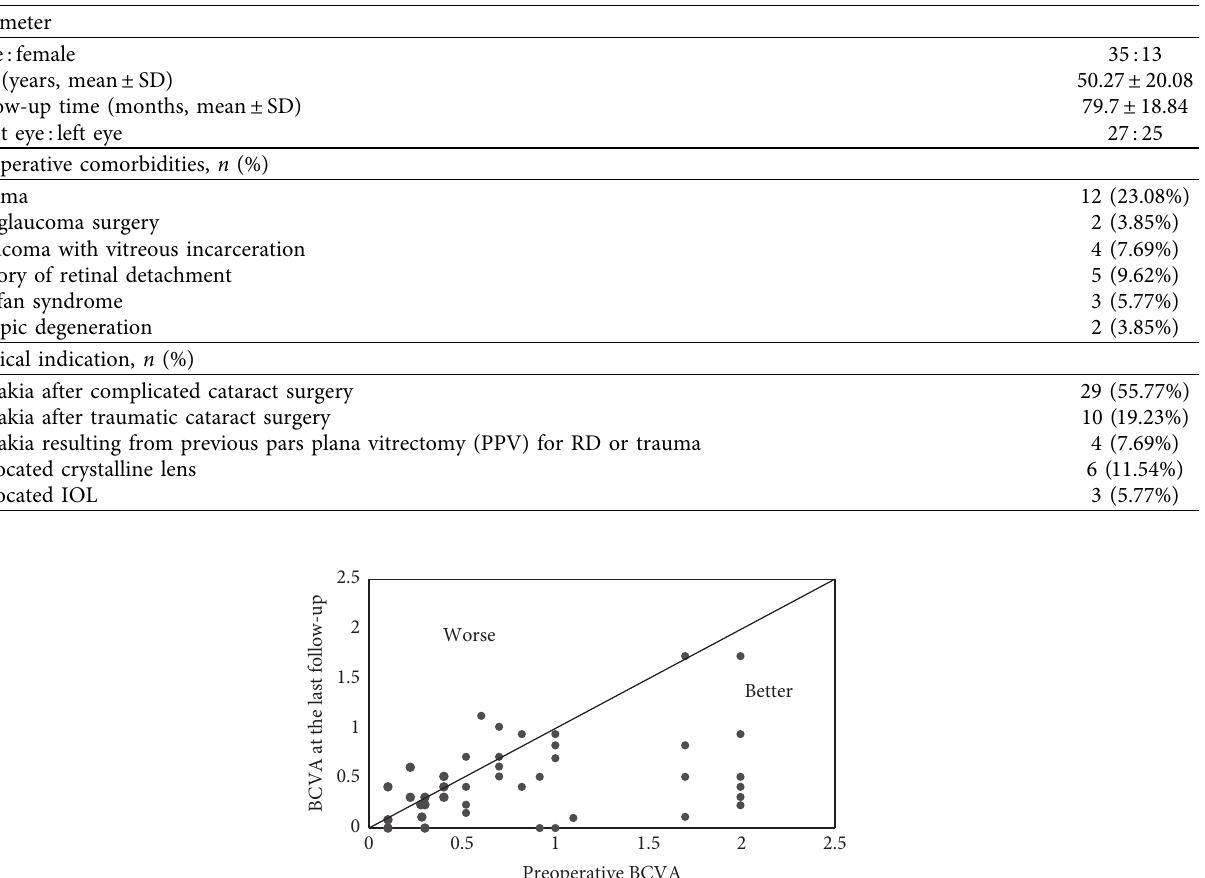
Table 1: Patient characteristics.